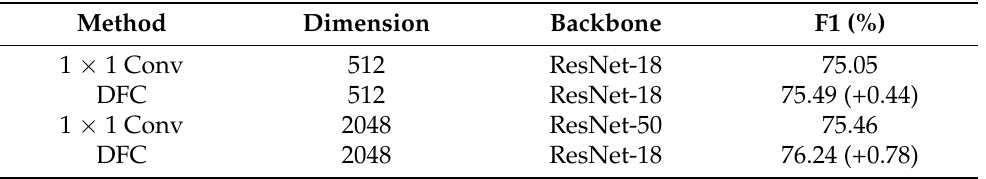
Table 8. The effect of different channel dimensions in DFC. 1 × 1 Conv means 1 × 1 convolution.